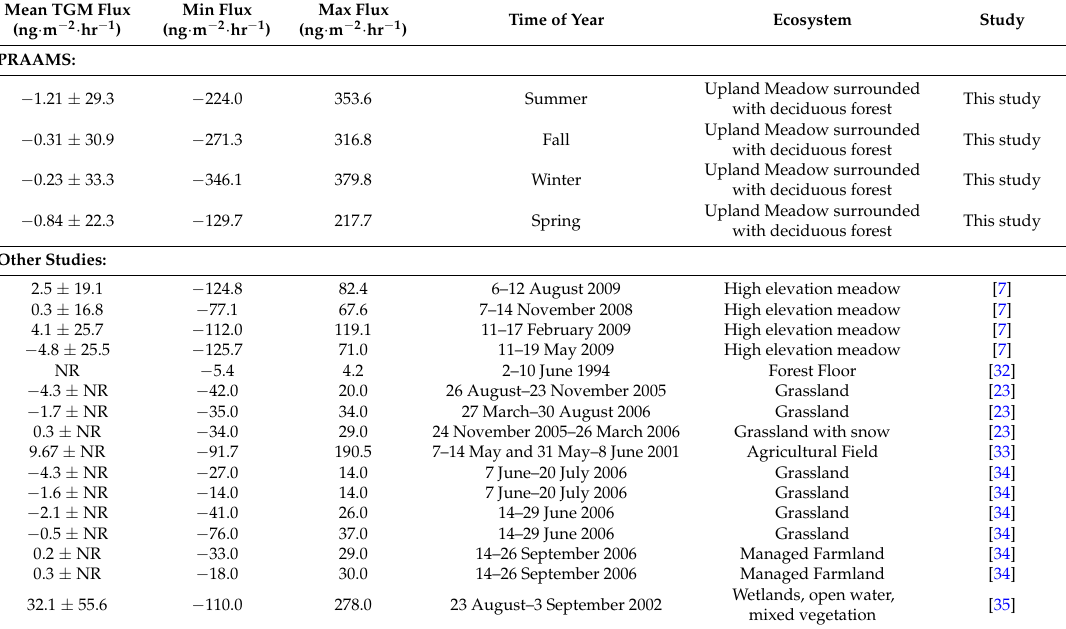
Table 3. A comparison of GEM fluxes measured at PRAAMS and other